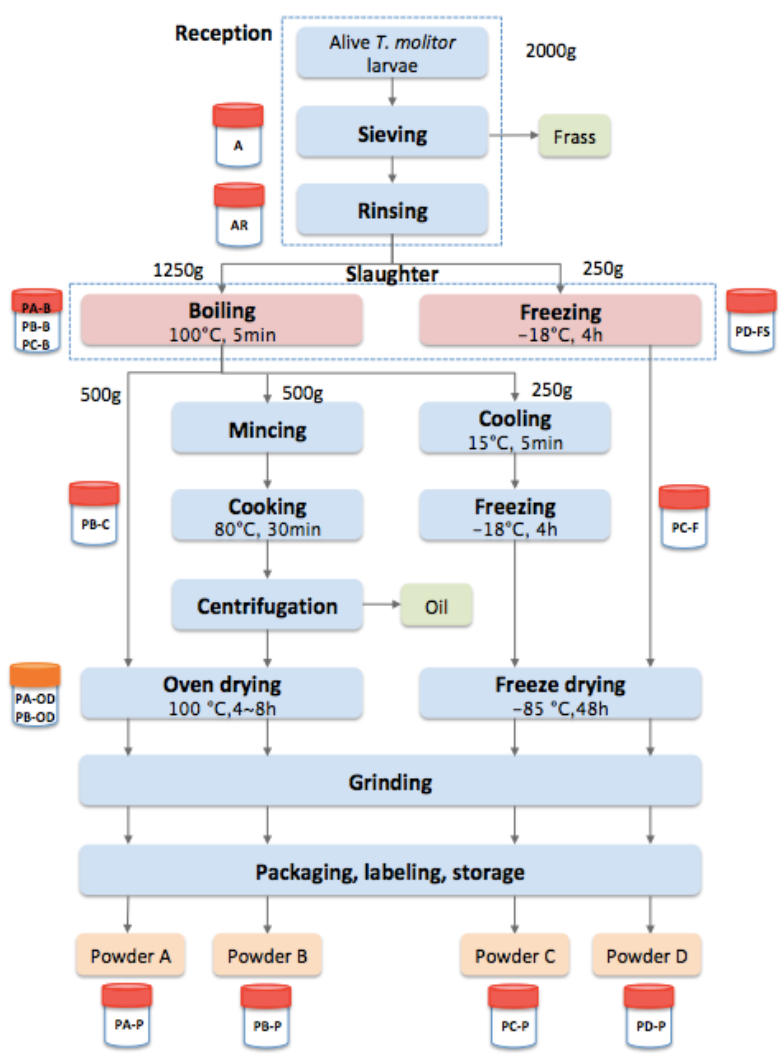
Figure 1. Flowchart of mealworm powder processing pathways and samples collected (adapted from [14]).